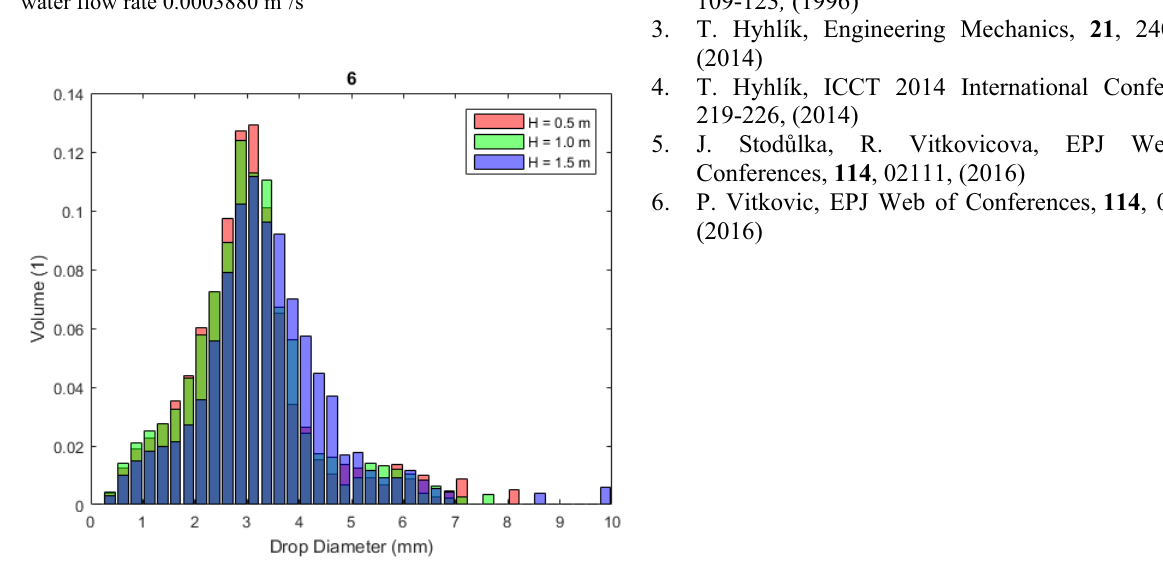
Fig. 14. Drop size histogram based on volume for the mean water flow rate 0.0004735 m 3